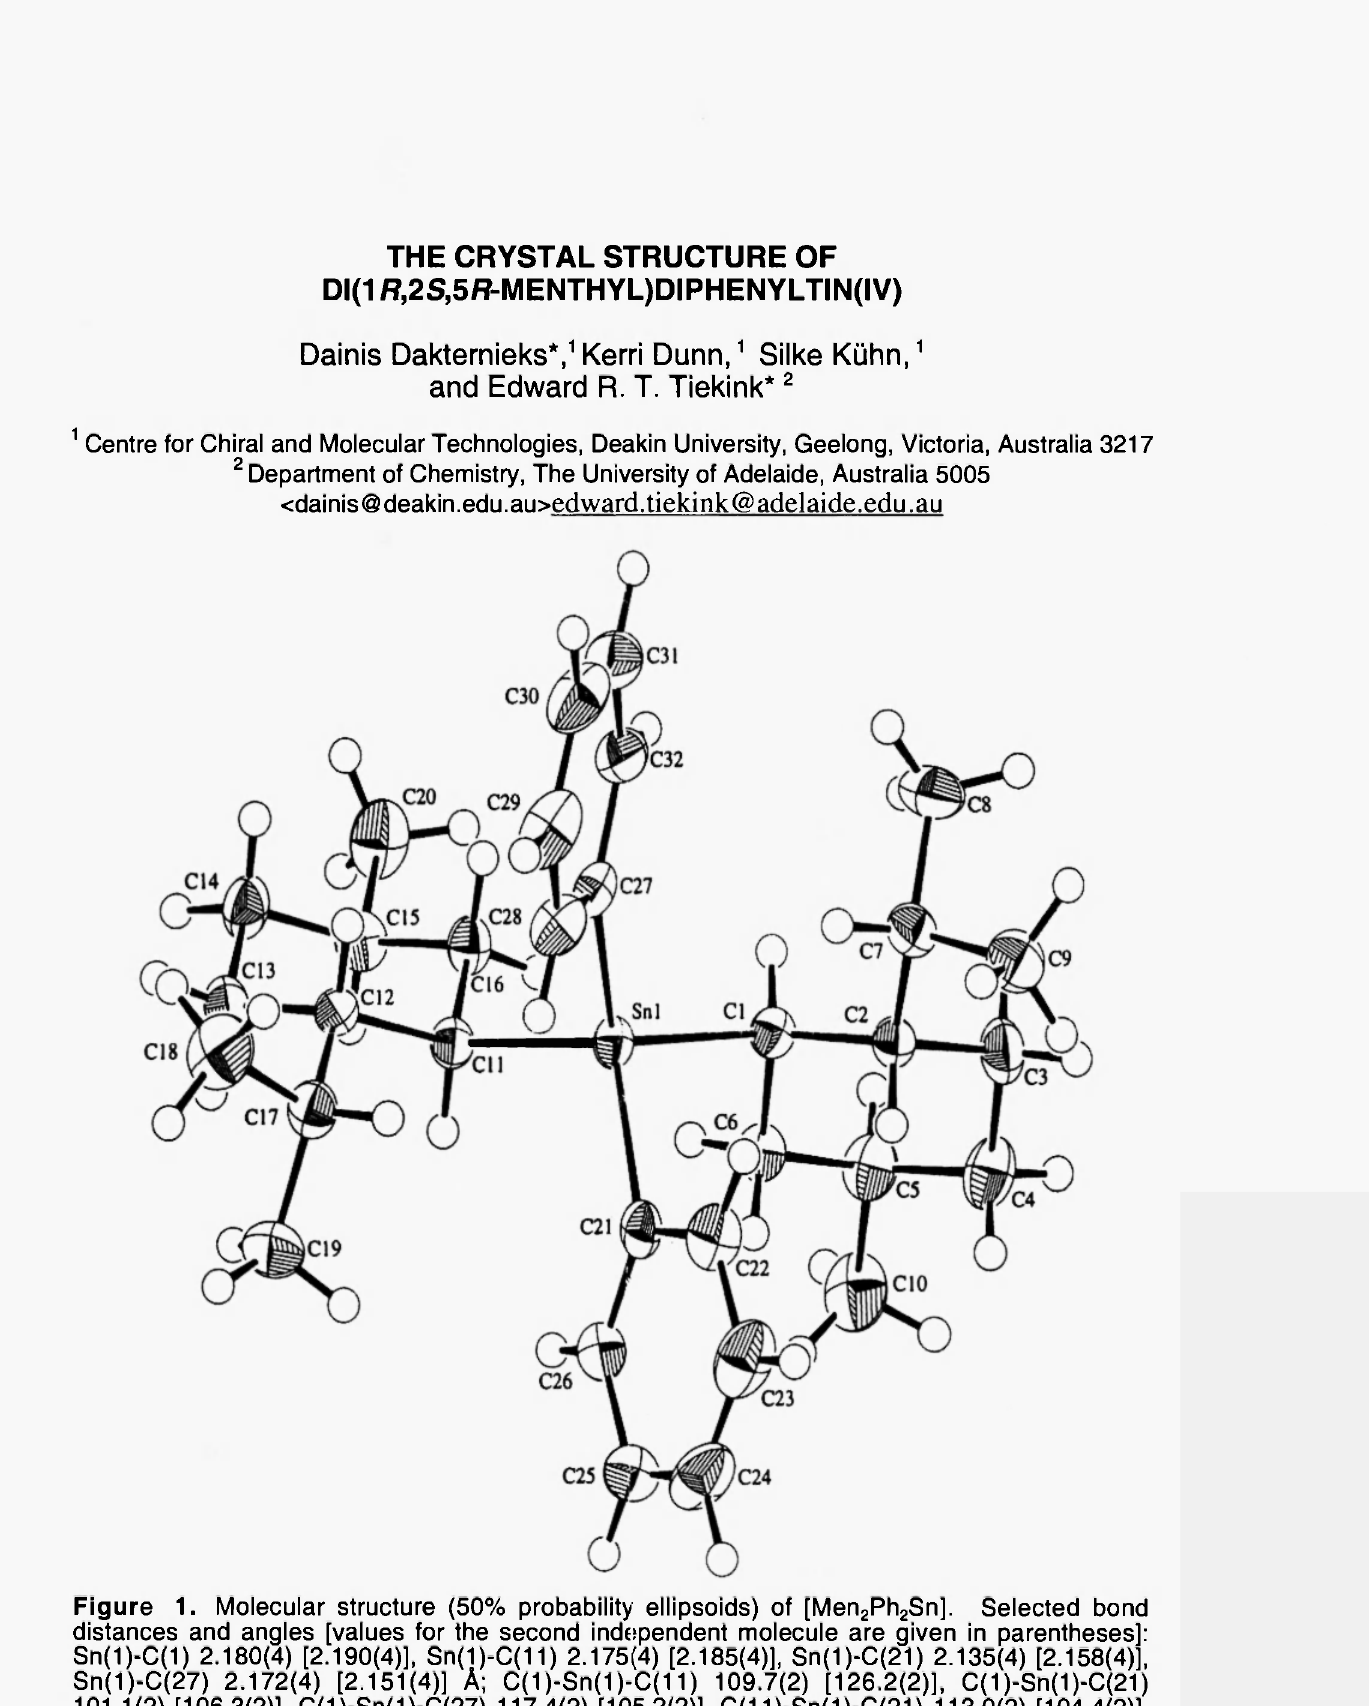
Figure 1. Molecular structure (50% probability ellipsoids) of [Men 2 Ph 2 Sn], Selected bond distances and angles [values for the second independent molecule are given in parentheses]: Sn(1)-C(1) 2.180(4) [2.190(4)], Sn(1)-C(11) 2.175(4) [2.185(4)], Sn(1)-C(21) 2.135(4) [2.158(4)], Sn(1)-C(27) 2.172(4) [2.151(4)] Ä; C(1)-Sn(1)-C(11) 109.7(2) [126.2(2)], C(1)-Sn(1)-C(21) 101.1(2) [106.3(2)], C(1)-Sn(1)-C(27) 117.4(2) [105.2(2)], C(11)-Sn(1)-C(21) 113.0(2) [104.4(2)], C(11)-Sn(1)-C(27) 108.5(1) [107.3(2)], C(21)-Sn(1)-C(27) 107.1(2)